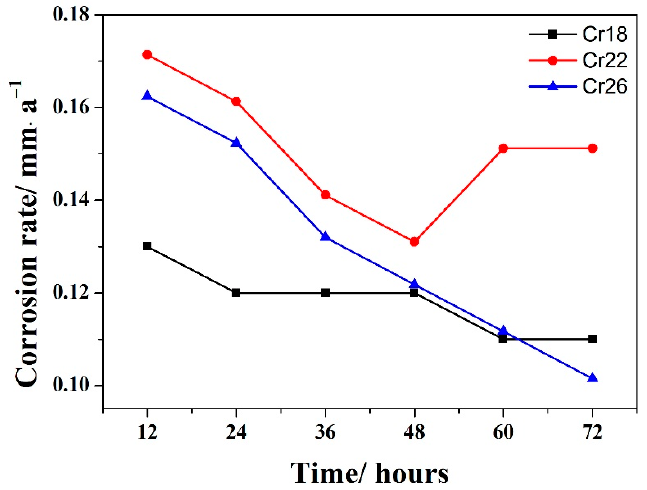
Figure 3. Corrosion rate (R) versus time curve of laser cladding Ni-Cr-Mo alloy coatings in 50 wt.% H 2 SO 4 solution at 60 °C .